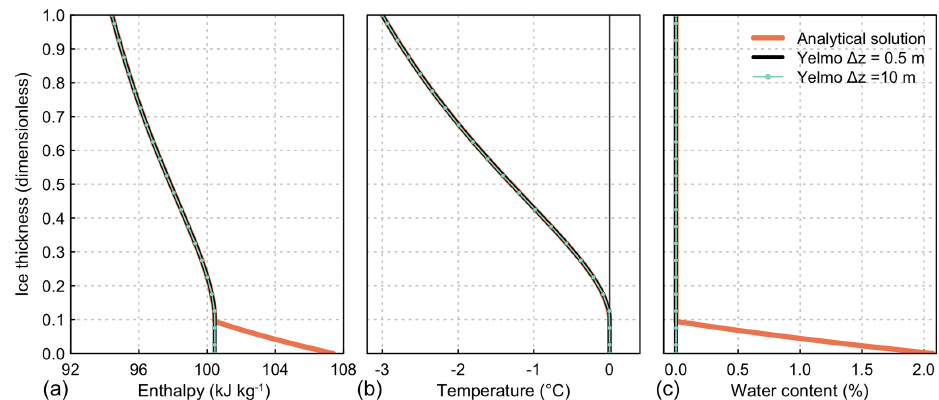
Figure 6. Steady-state vertical profiles of (a) enthalpy, (b) temperature and (c) water content for the thermodynamic benchmark experiment Exp. B (Kleiner et al., 2015). The analytical solution (thick, light-red lines) is compared to Yelmo results for a vertical resolution of (cid:49)z = 0 . 5m ( n z = 400, black lines) and (cid:49)z = 10m ( n z = 20, light green lines). The vertical grey line in (b) shows the pressure-melting point as prescribed in this experiment. Note that where the analytical solution is not visible, it overlaps with the Yelmo results.